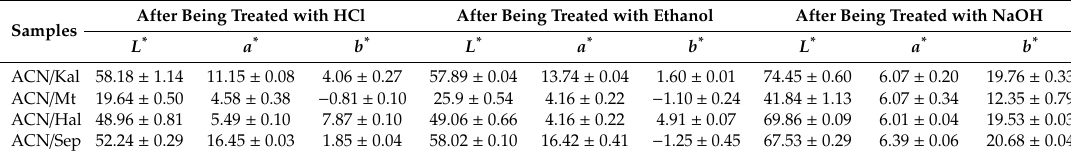
Table 4. Color parameters of the ACN/clay minerals before and after being exposed to HCl and NH 3 atmospheres for five cycles.